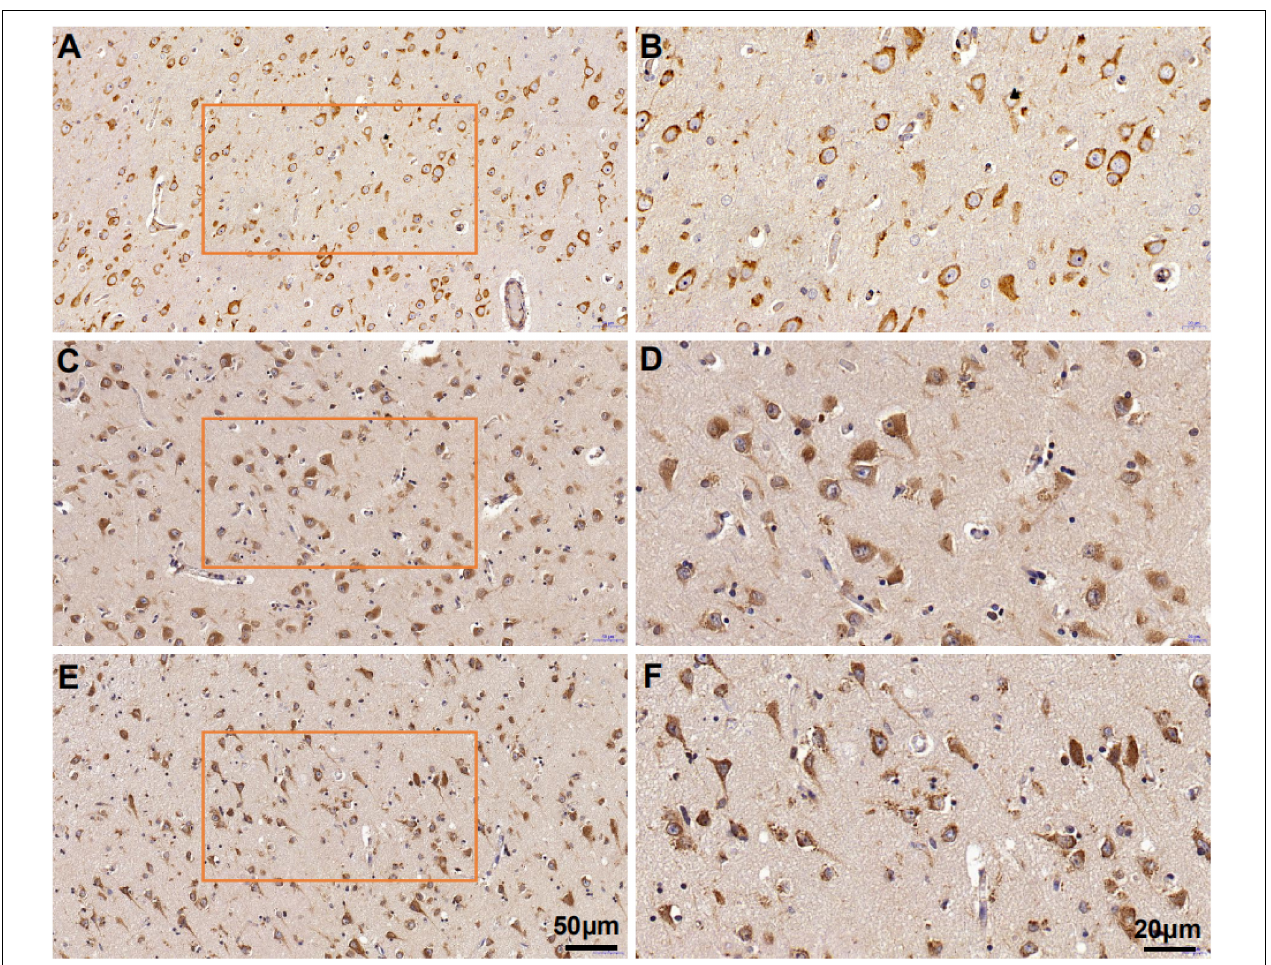
FIGURE 7 | Mesencephalic astrocyte-derived neurotrophic factor expression in the ITGC of AD, pre-AD, and control cases detected by immunohistochemistry. (A–F) MANF expression in non-dementia control (A,B) , pre-AD (C,D) , and AD (E,F) samples shown at low (20 × ) (A,C,E) and high (40 × ) (B,D,F) magnification.